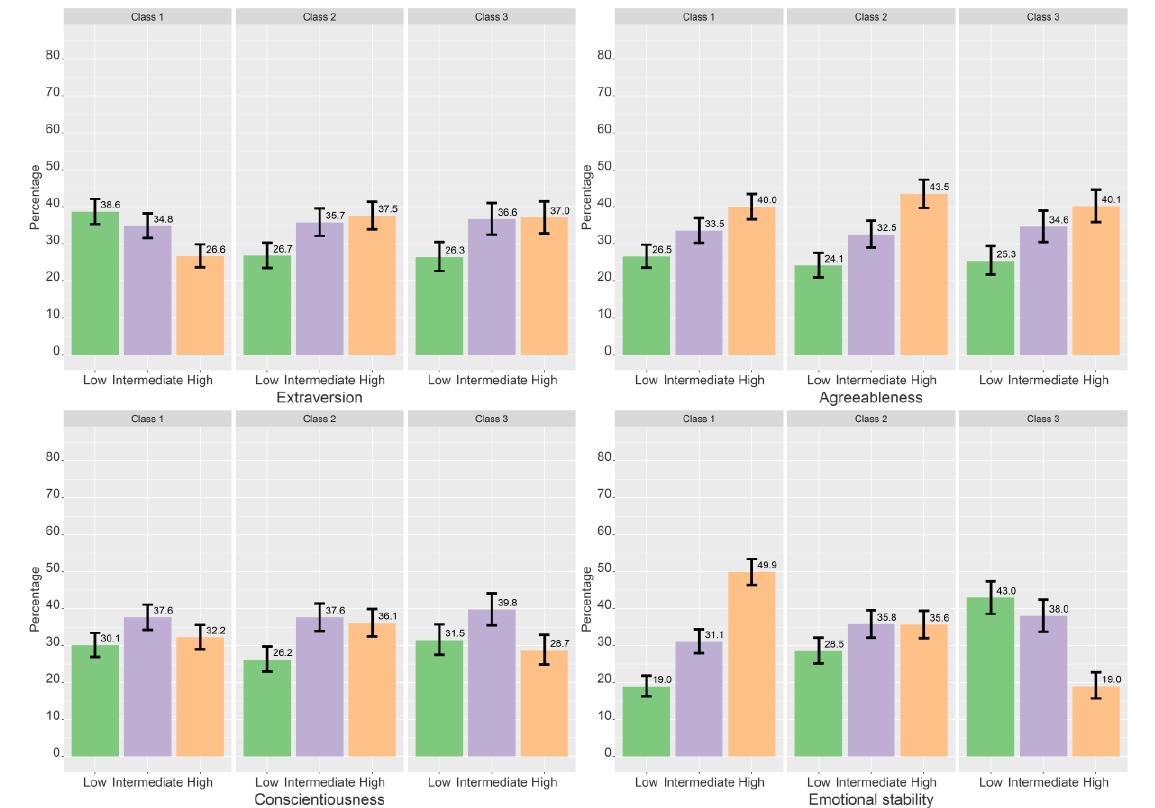
Figure 6. Crude proportions for each class across personality traits. Proportions based on most probable class belongingness. The error bars denote 95% confidence